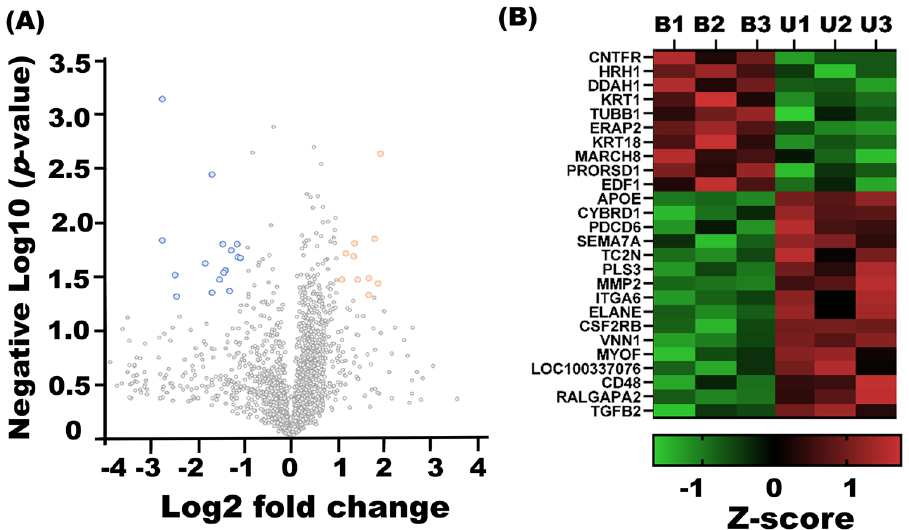
Figure 3. Volcano plot demonstrated the expression of milk sEV proteins from BLV-infected and uninfected cattle. Up/down-regulated sEV proteins were indicated in orange and blue colours, respectively. Proteins not classified as up/down-regulated were plotted in grey colour. X-axis and Y-axis indicated a more than two-fold change (in log2 scale) and − log10 with significance ( p < 0.05) ( A ). Heat map of hierarchical clustering indicated the candidates for differentially expressed proteins milk sEV from BLV-infected cattle. Up/down-regulated proteins were indicated by red/green colour, respectively ( B ). GraphPad Prism software, version 8 (https ://www. graph pad.com) was used to generate the volcano plot and heat map.